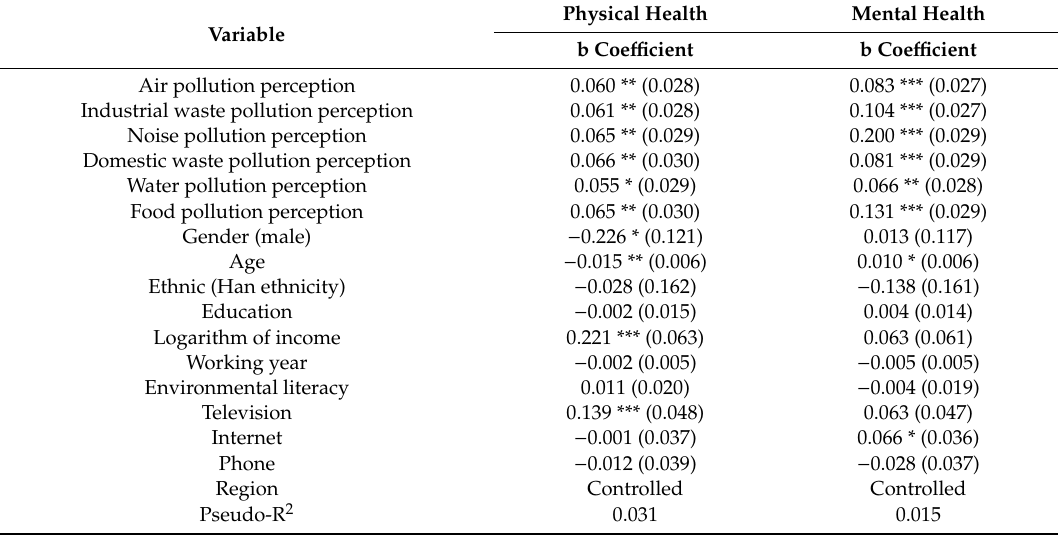
Table 2. Influences of ERP on migrant construction workers’ physical and mental health ( N =